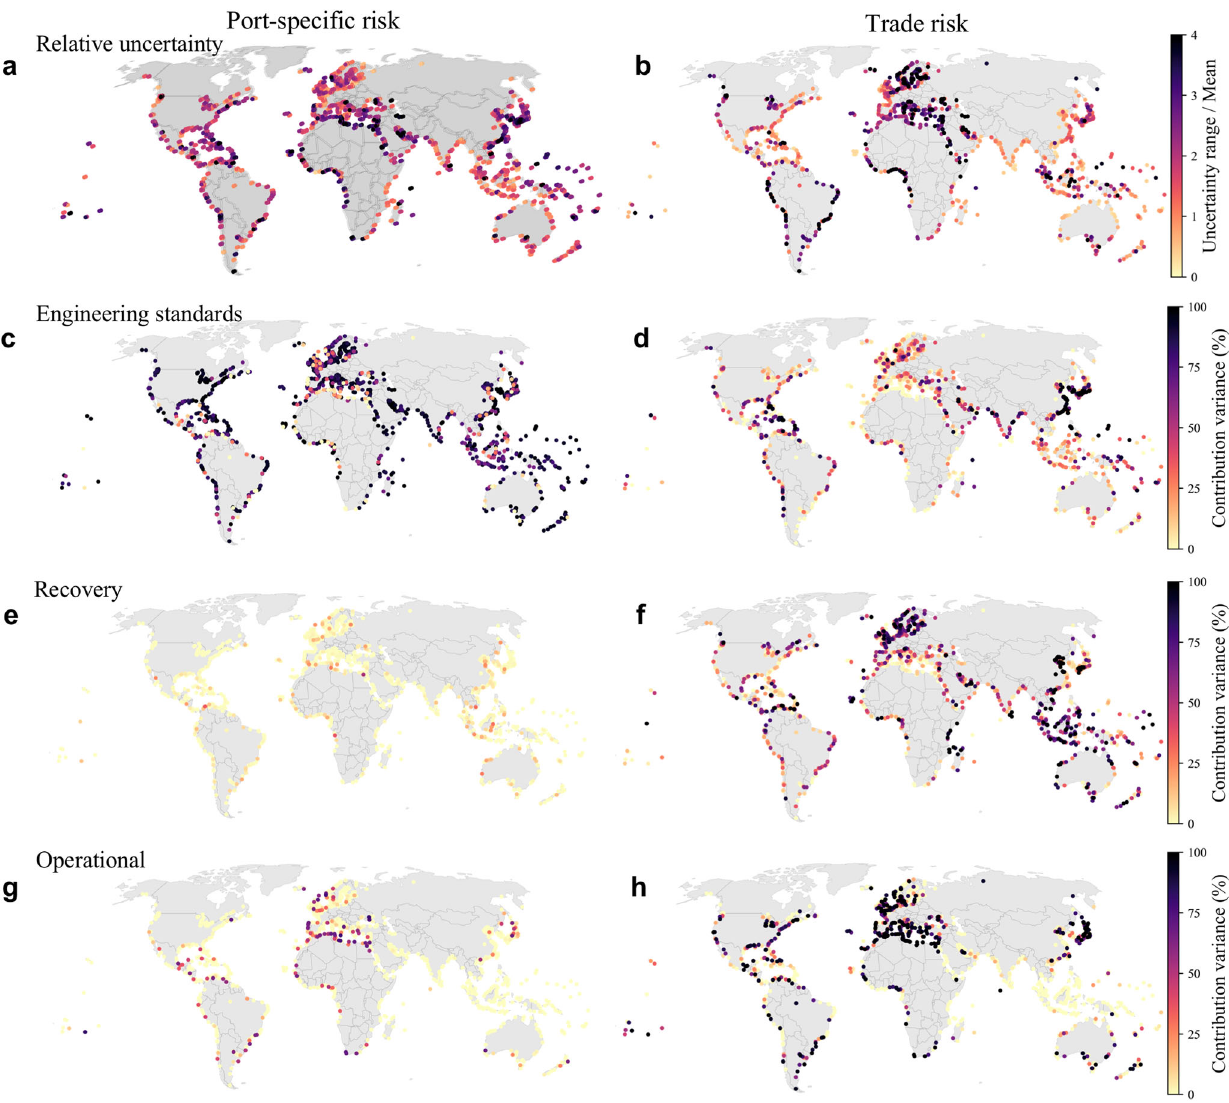
Fig. 4 Uncertainty range and sensitivity analysis of resilience parameters. a The relative uncertainty, expressed as the 5 – 95th uncertainty range over the mean, over the 10,000 model realisation for the port-speci fi c risk. b Same as ( a ) but for trade risk. c The contribution of the input parameters re fl ects the uncertainty in the engineering standards of ports with respect to hazard impacts (depth-damage curves) to the port-speci fi c risk model variance. d Same as ( c ) but for trade risk. e The contribution of the input parameters re fl ects the uncertainty in the recovery ability of ports with respect to hazard impacts (recovery curve, maximum recovery duration) to the port-speci fi c risk model variance. f Same as ( e ) but for trade risk. g The contribution of the input parameters re fl ecting the uncertainty in the operability of ports with respect to climate extremes (wave height, wind, temperature and overtopping) to the port-speci fi c risk model variance. h Same as ( g ) but for trade